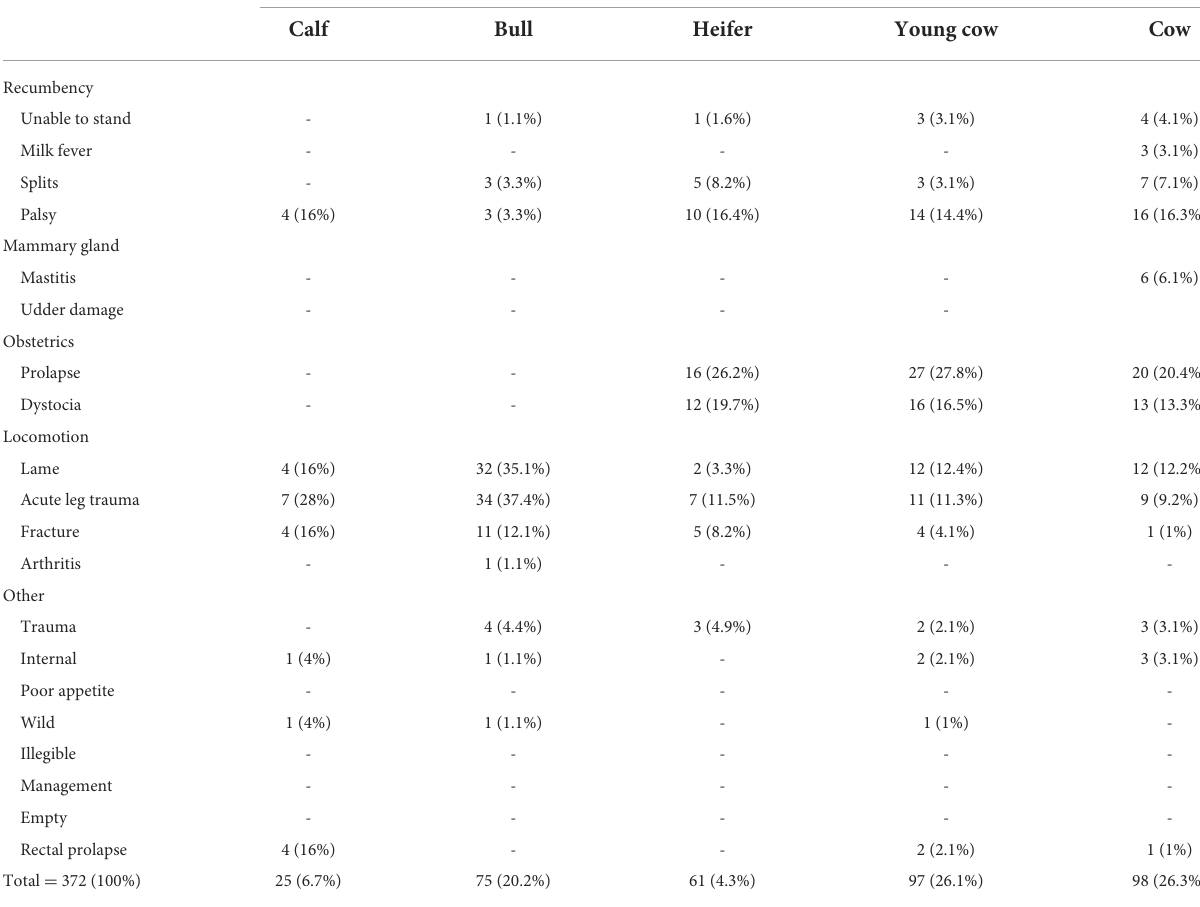
TABLE 5 Descriptive table showing number and percentage of total of each animal type within each subcategory of OFES, n = 372, only including animals from a beef production system. Causes Animal type Calf Bull Heifer Young cow